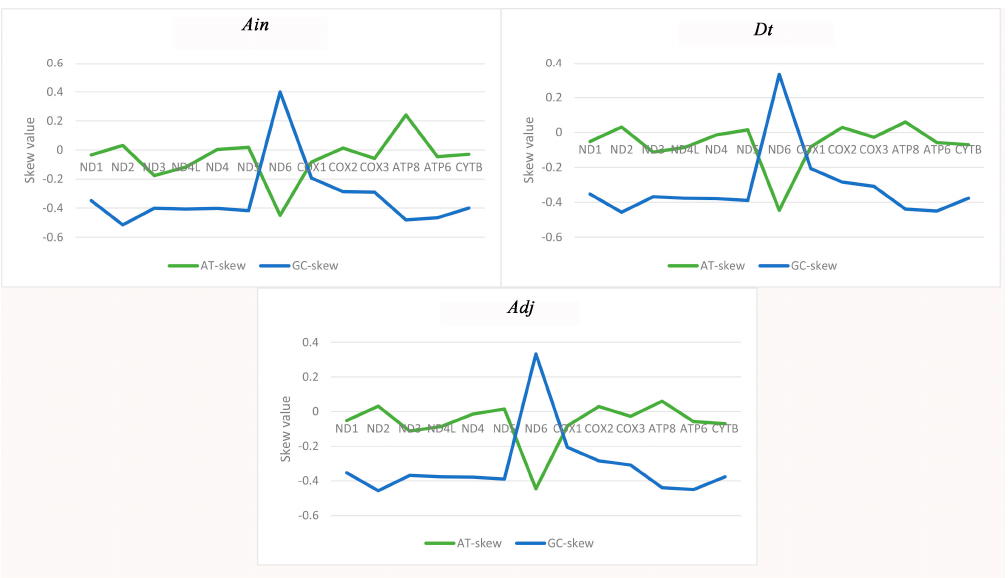
Figure 2 . Graphical illustration showing the AT- and GC-skew in the protein-coding genes (PCGs) of the mitochondrial genome of Alectis indicus ( Ain ), Decapterus tabl ( Dt ), and Alepes djedaba (Adj).